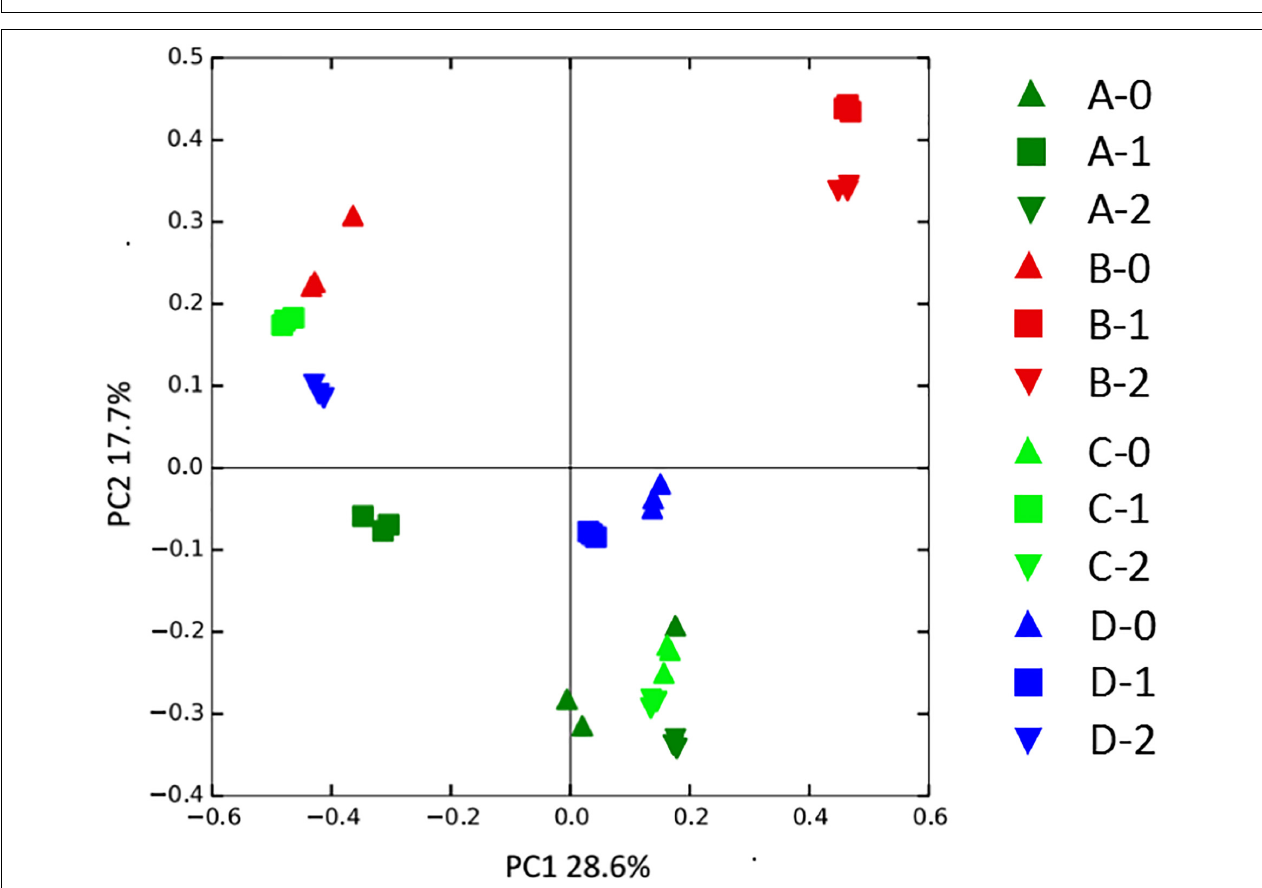
FIGURE 4 | PCoA analysis of the fungal community variation among all sediment samples. A, B, C, D: location; 0: 0.05 m depth sediment (surface); 1: 1 m depth sediment; 2: 2 m depth sediment.